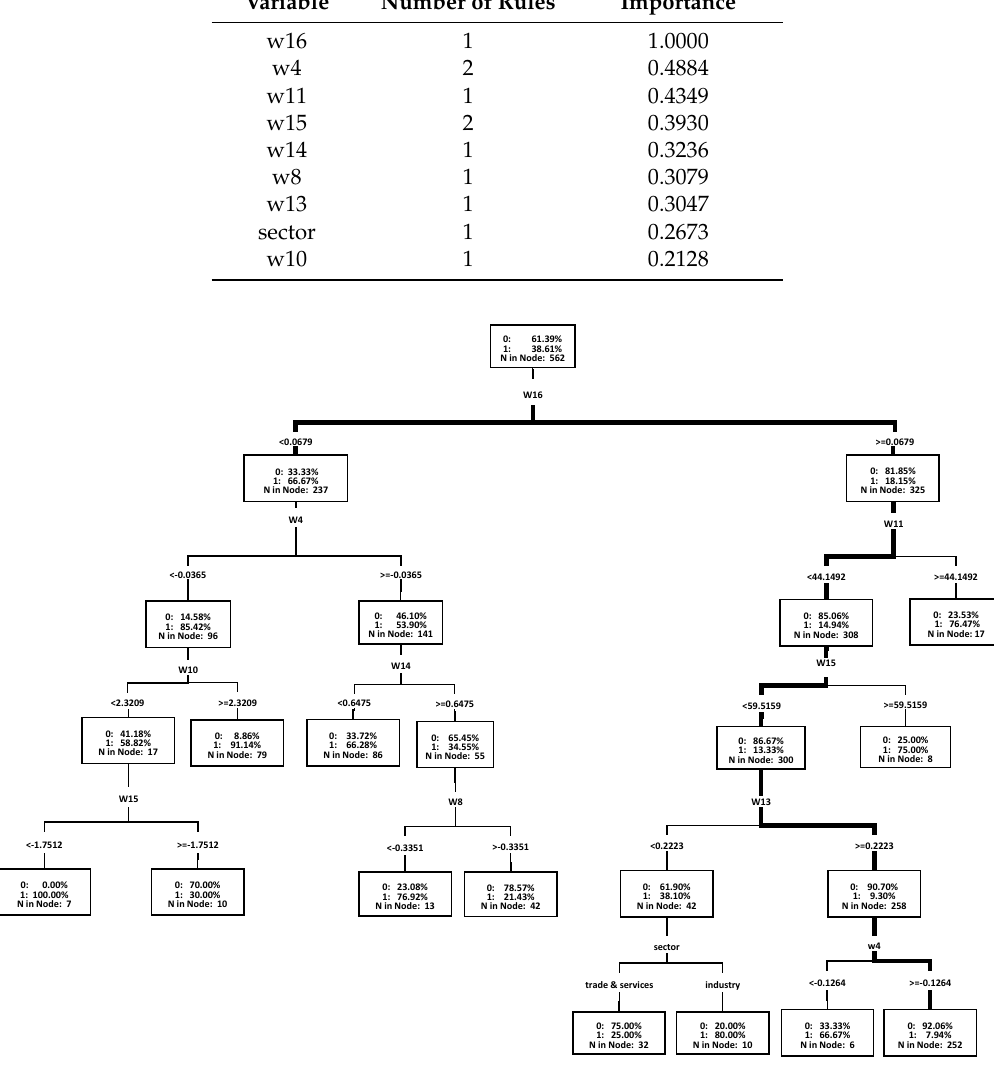
Figure 4. Results of the estimation of the decision